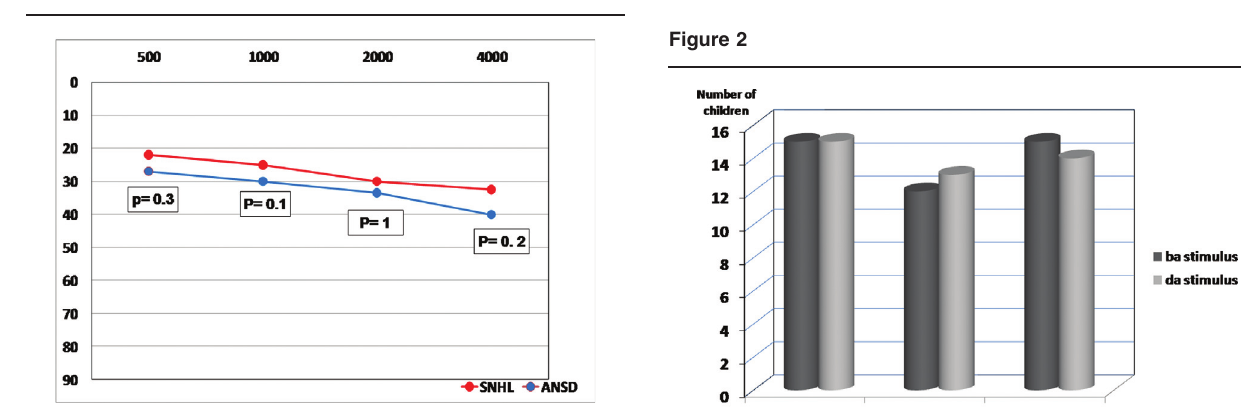
Comparable aided sound field thresholds in auditory neuropathy spectrum disorder (ANSD) and sensorineural hearing loss (SNHL) children.